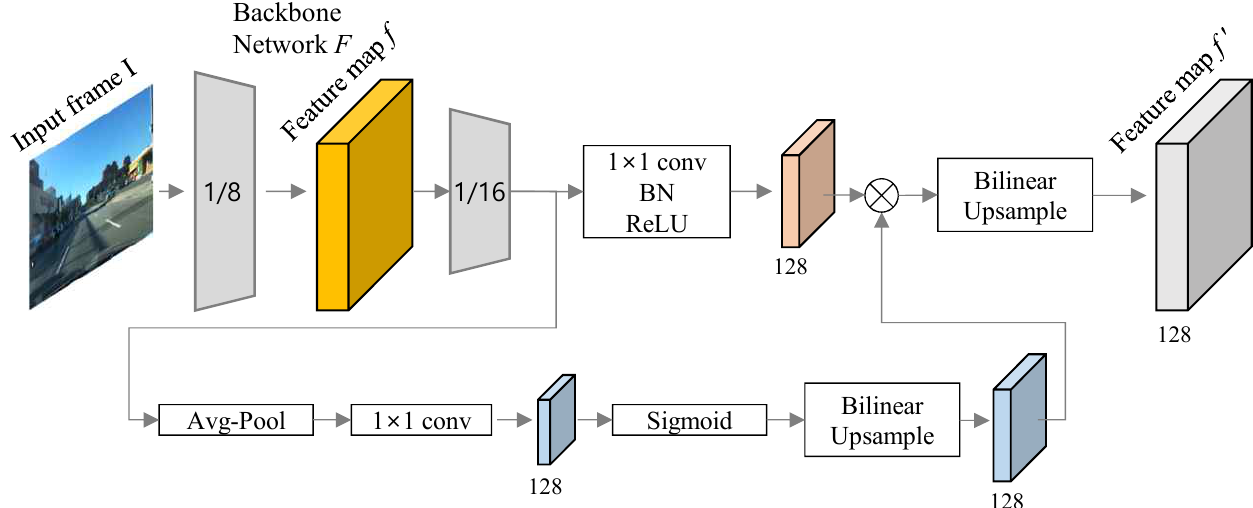
Figure 2. The architecture of encoder for the feature extraction. The light-weight segmentation head is delivered in LR-ASPP module to mix features from multiple resolutions.